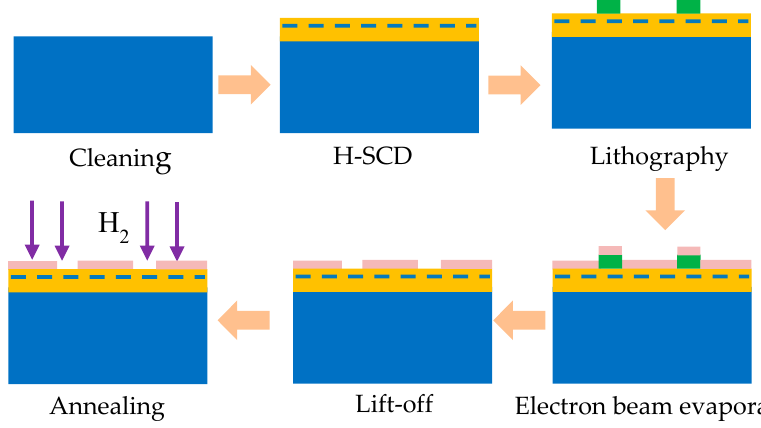
Figure 1. The fabrication process of Pt/Au/H-SCD.